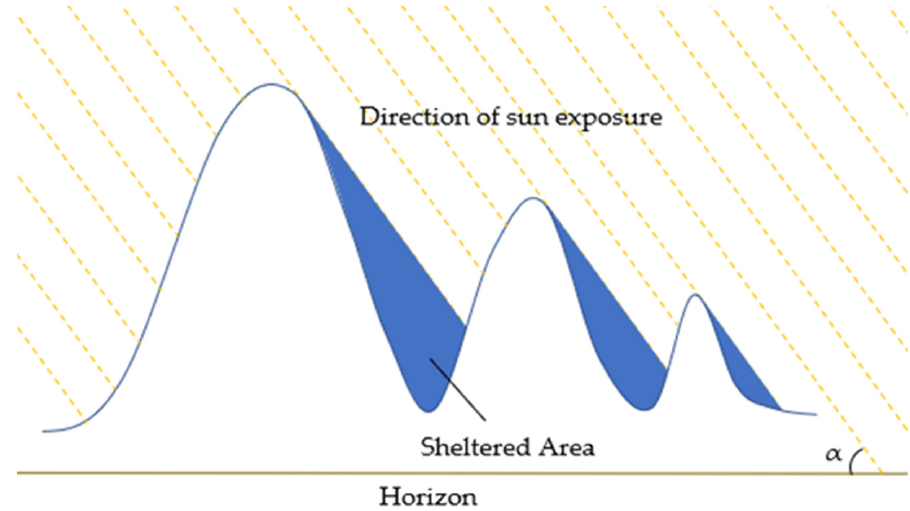
Figure 3. Hillshade simulation diagram. The yellow dotted lines represents the direction of incident sunlight, the brown line represents the horizon and α represents the solar altitude.